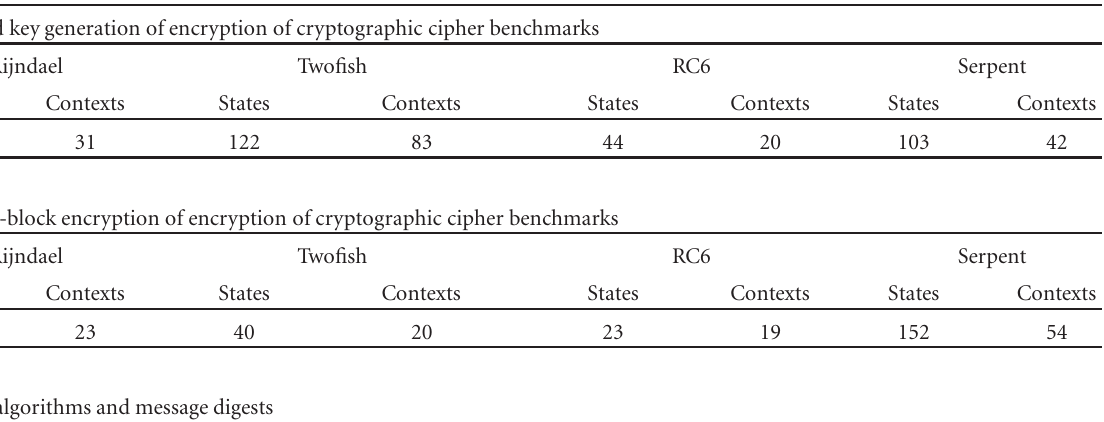
Table 2: Complexity of the schedules of benchmark